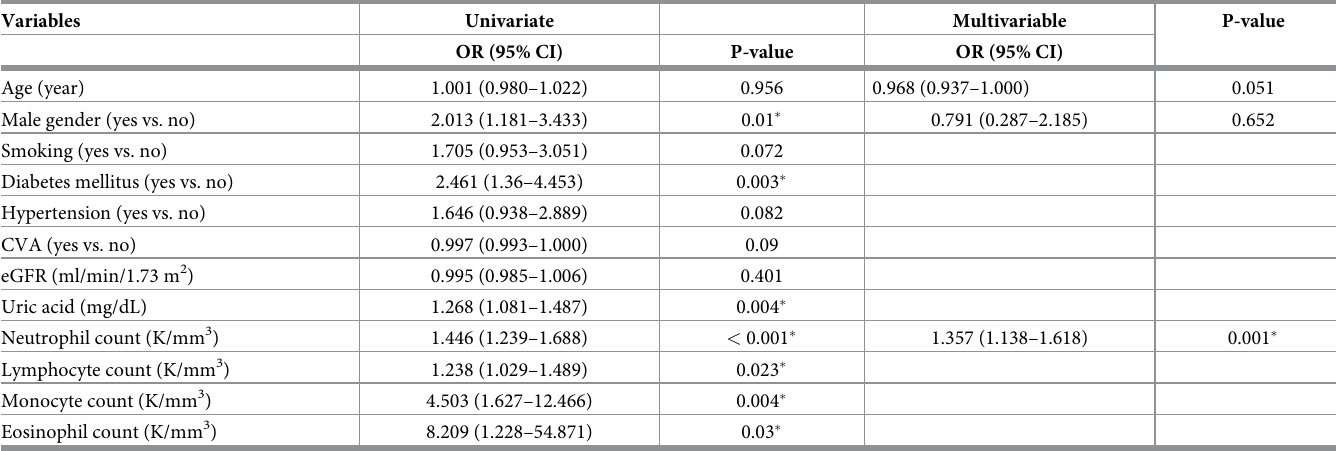
(95% confidence interval = 0.714–0.912). The optimal cutoff value for plasma creatine was dif- ficult to find with sensitivity and specificity > 0.6, and an area under the curve was 0.566 (95% confidence interval = 0.431–0.70). The optimal cutoff value for proteinuria amount was also problematic to find with sensitivity and specificity > 0.6, and an area under the curve was 0.53 (95% confidence interval = 0.407–0.654). Table 6. Univariate and multivariate analysis of variables associated with rapid progression of